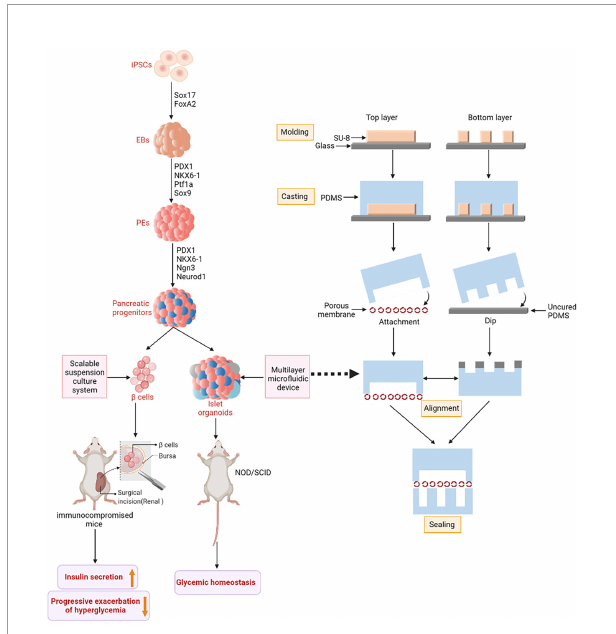
FIGURE 2 | IPSCs-derived islet function replacement. iPSCs differentiate into insulin-secreting cells under the action of related transcription factors. Embryoid bodies (EBs) are formed under the in fl uence of SLEy-related high mobility group box 17 (SOX17) and Forkhead box A2 (FoxA2). Pancreatic and duodenal homeobox 1 (PDX1), NK6 Homeobox 1 (NKX6-1), Pancreas Associated Transcription Factor 1a (PTF1a) and SOX9 guide to pancreatic Endoderms (PEs). Finally, PDX1, NKX6-1, Neurogenin 3 (Ngn3) and Neuronal Differentiation 1 (NeuroD1) differentiated into pancreatic progenitor cells. Pancreatic progenitor cells are directed to produce glucose- responsive b -cells. The fi gure on the right shows the fabrication method of micro fl uidic device. SU-8 photoresist is rotated onto two clean glass wafers and then selectively cured under ultra violet (UV) light using different masks. The mixture of Polydimethylsiloxane (PDMS) monomer and hardener then produces a two-layer copy of PDMS. Finally, the two PDMS replicas are sealed together with an intermediate porous